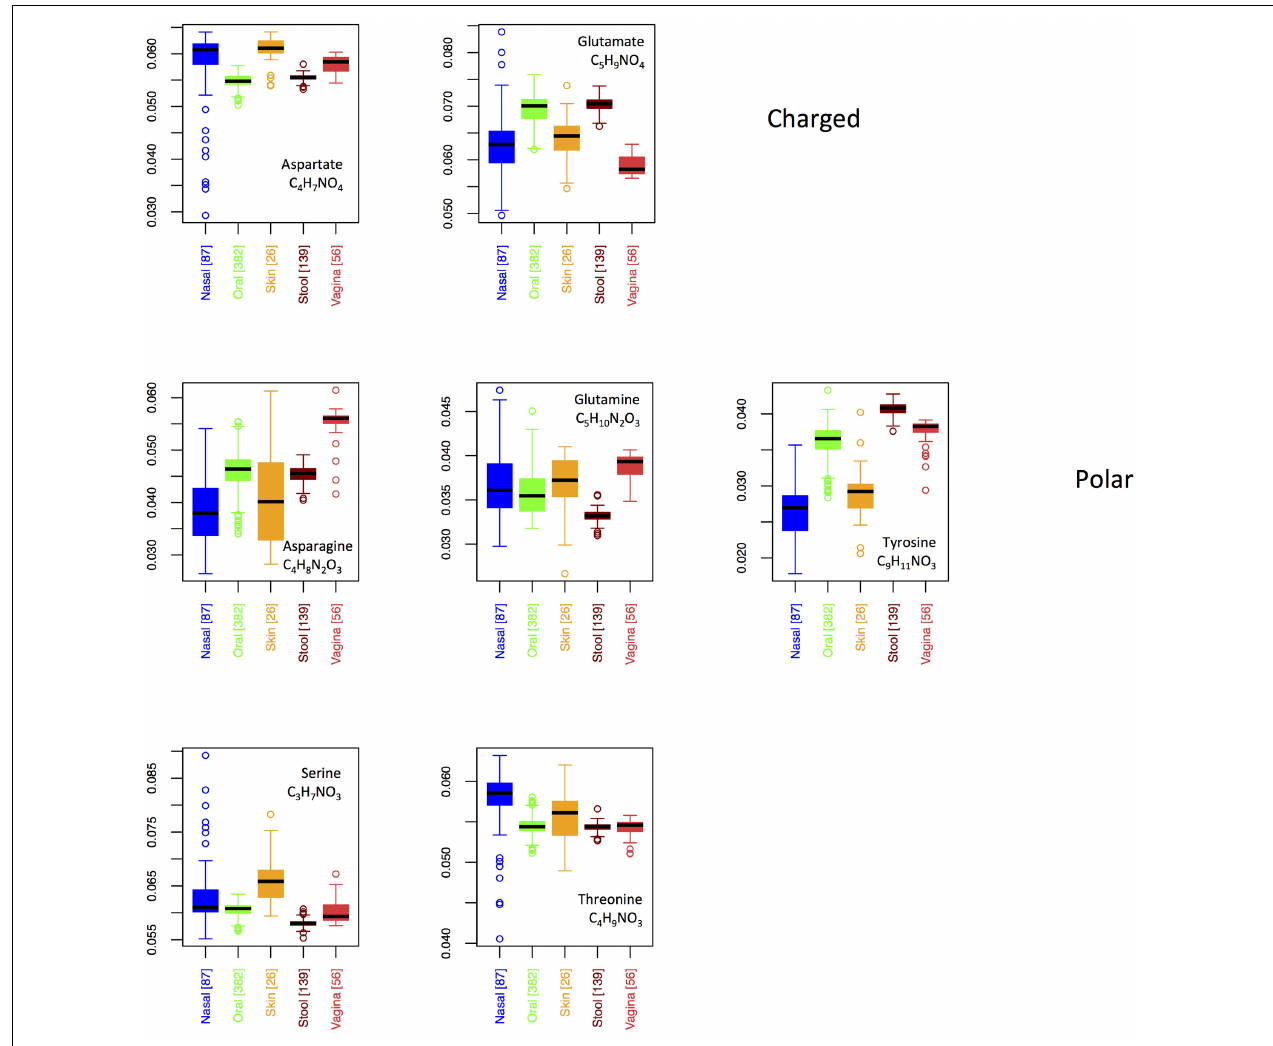
FIGURE 8 | Boxplots showing the fractions of the O-rich amino acids as a function of body site. Amino acids are grouped according to their chemical